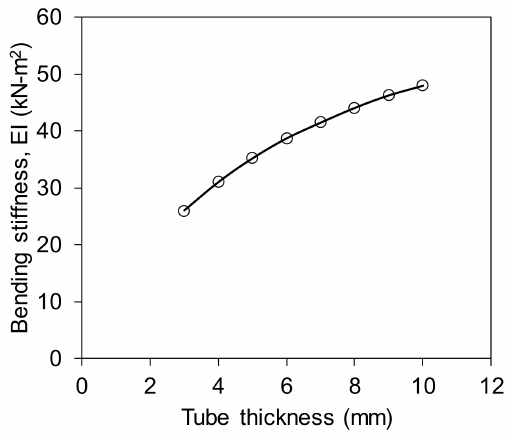
Figure 8. Effect of tube thickness on bending